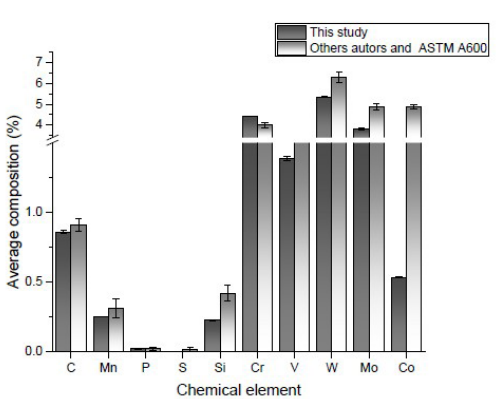
Figure 2. Chemical composition comparison of AISI M35